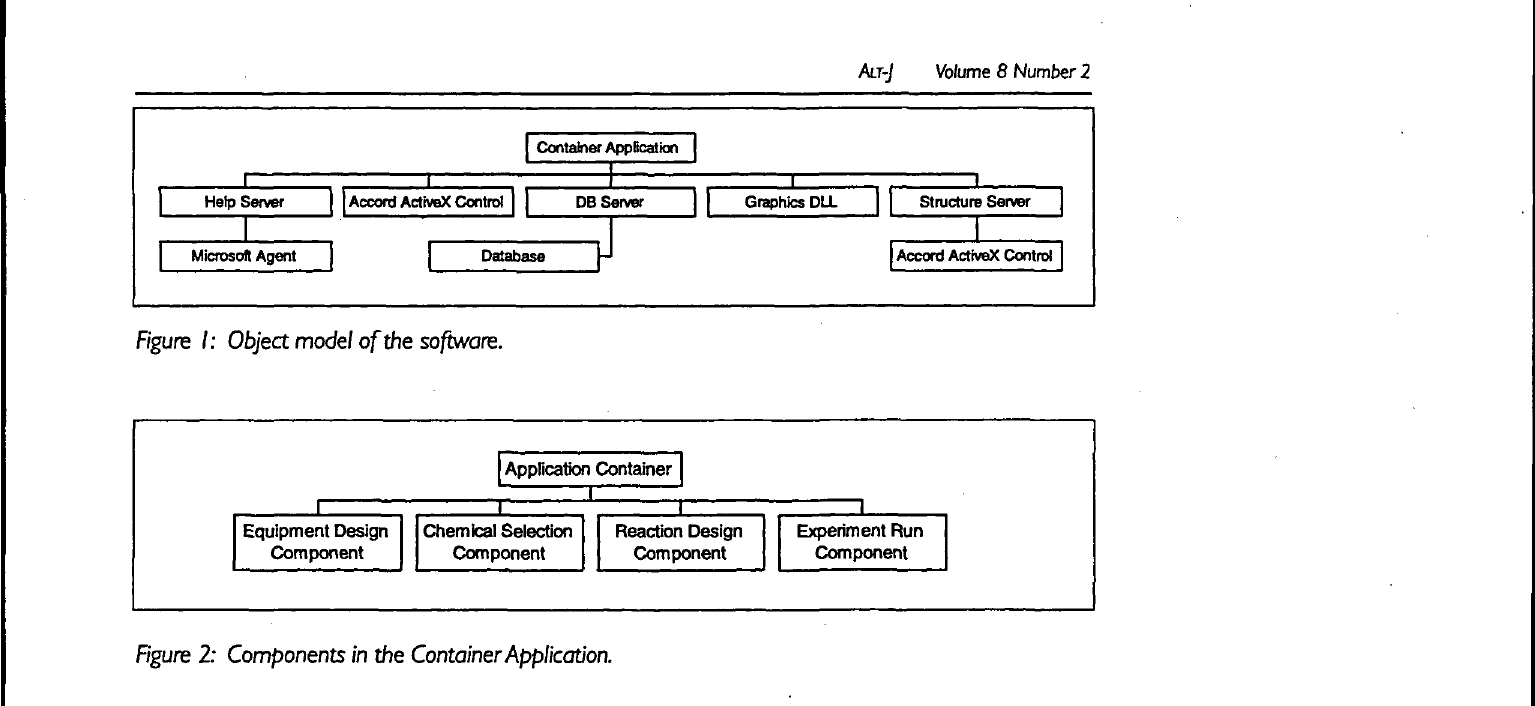
Figure 2: Components in the Container